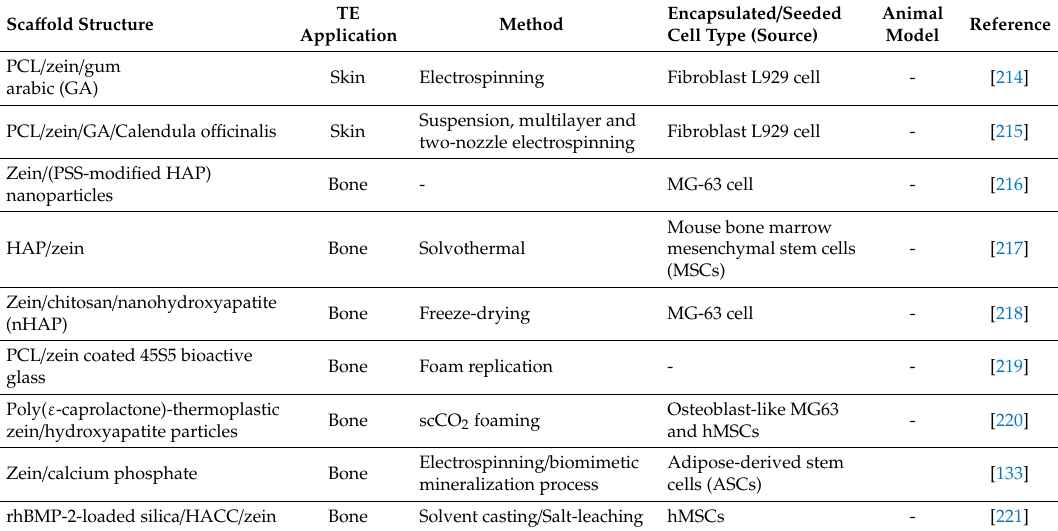
Table 7. Studies using zein protein-based matrices / sca ff olds for tissue engineering (TE) applications. Sca ff old